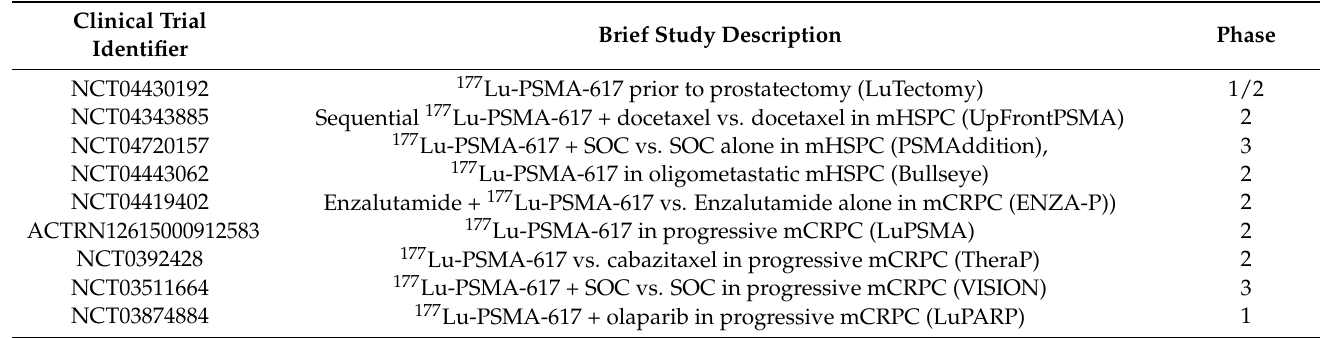
Figure 1. Schematic overview of selected PSMA theranostics clinical trials as of June 2021. Table 2. Selected key PSMA theranostics clinical trials as of June